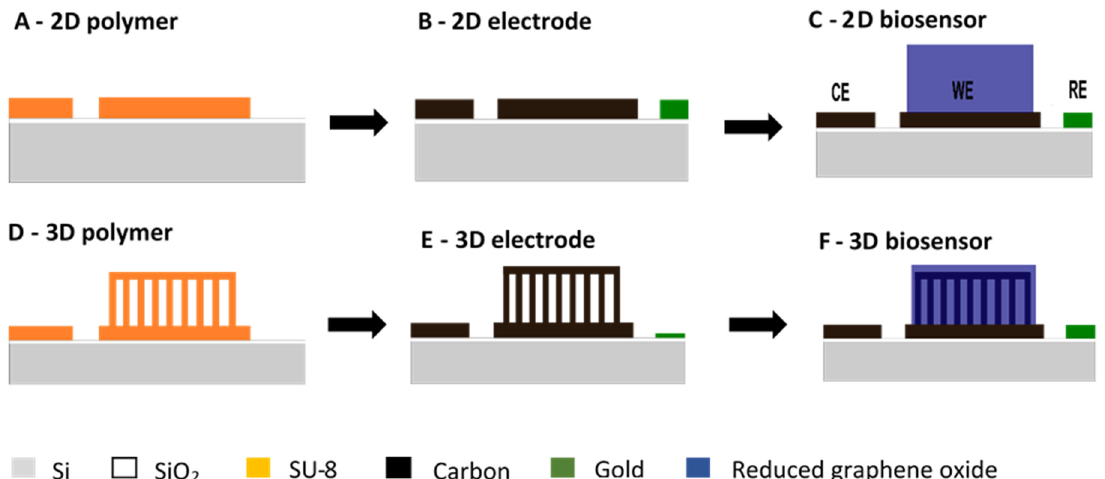
Figure 1. Schematic of 2D ( A – C ) and 3D ( D – F ) carbon biosensor fabrication: ( A , D ) polymer precursor template fabricated by multiple UV photolithography processes with the negative epoxy photoresist SU-8; ( B , E ) pyrolytic carbon fabricated by pyrolysis of the corresponding polymer precursor template; ( C , F ) functionalization of WE with reduced graphene oxide.